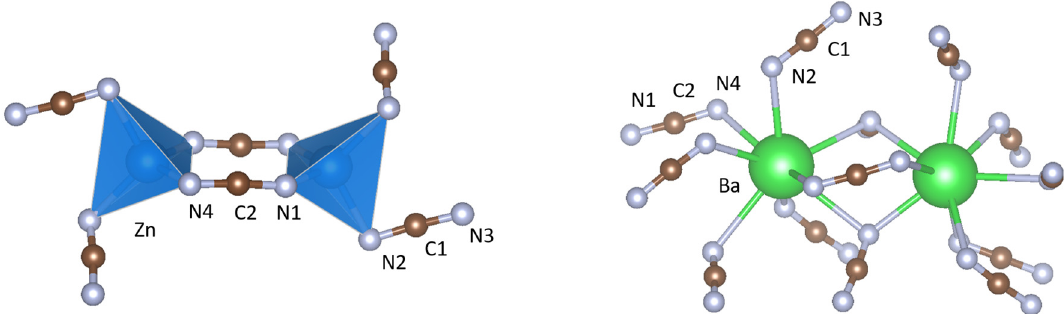
Figure 2. Coordination environments of ( left ) zinc and ( right ) barium in BaZn(NCN) 2 .